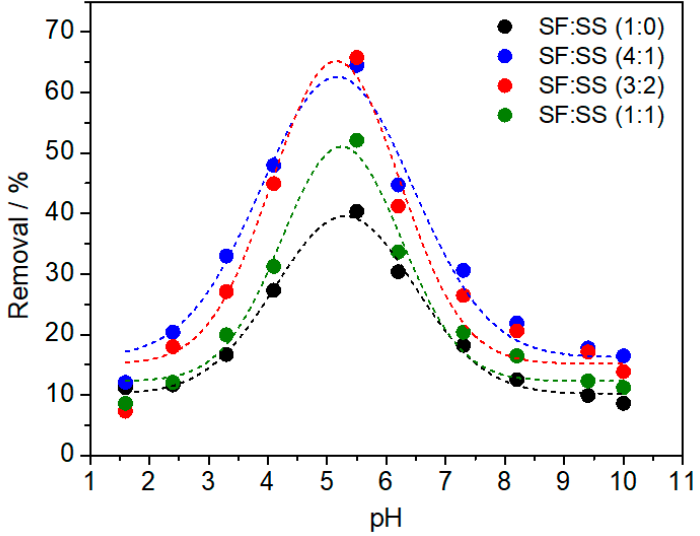
Figure 10. Removal capacity of Cu 2+ using various SF:SS biocomposite adsorbents at different pH solutions.